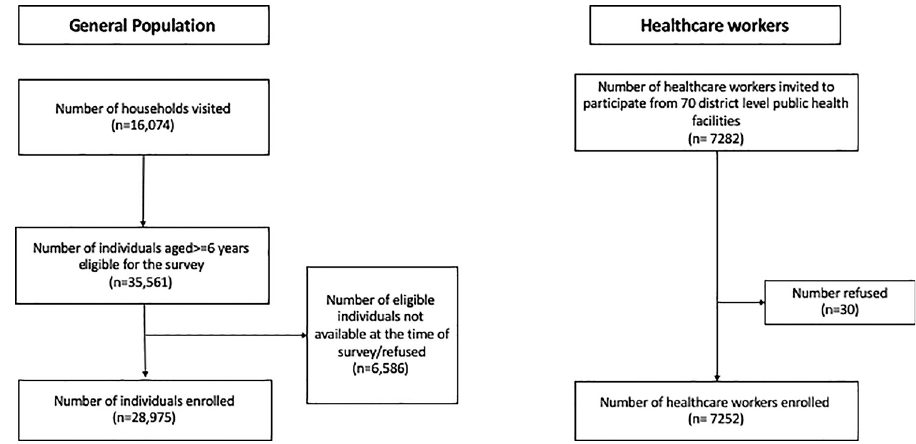
Fig 1. Flowchart of participant